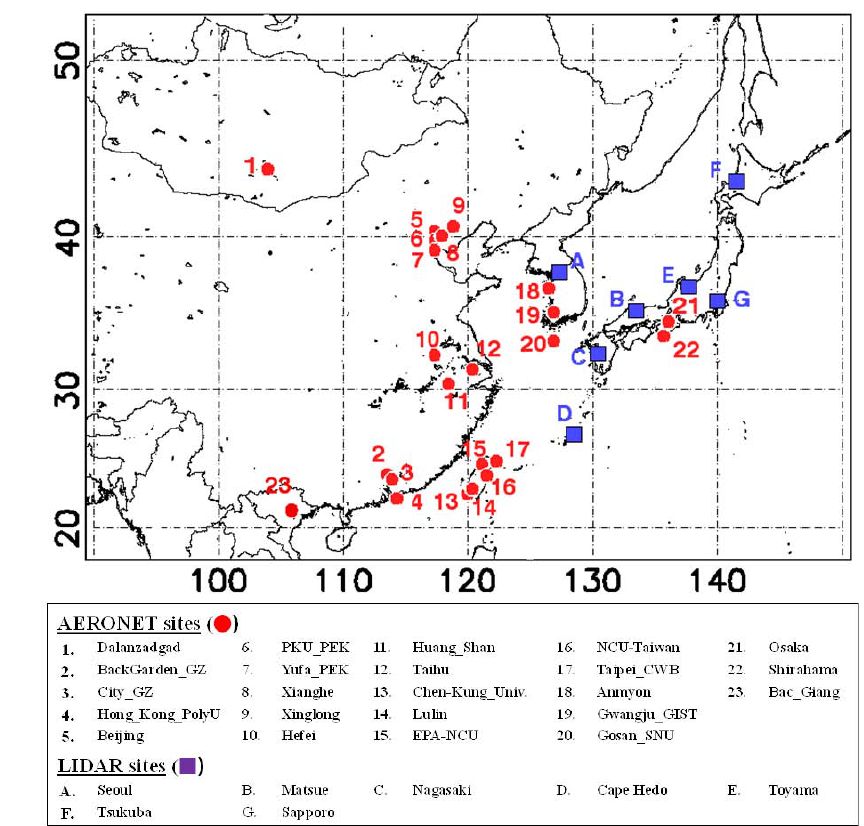
Fig. 4. Locations of the 23 AERONET sites and 7 ADNET (LIDAR network) sites: AERONET AODs were obtained from 22 AERONET sites, except for the Bac Giang site, and AERONET SSAs were obtained from 10 AERONET sites (Dalanzadgad, Hong Kong PolyU, Chen-Kung Univ., EPA-NCU, Taipei CWB, Anmyon, Gosan SNU, Osaka, Shirahama and Bac Giang sites).